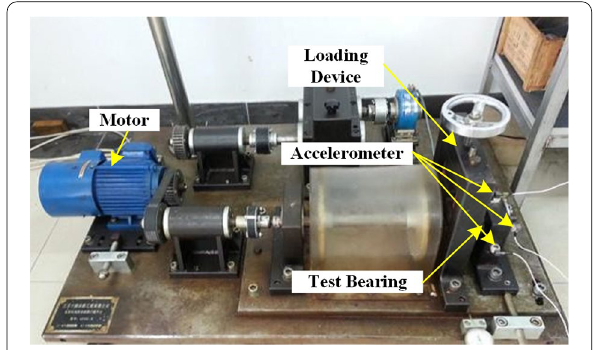
Figure 3 CWRU bearing test rig